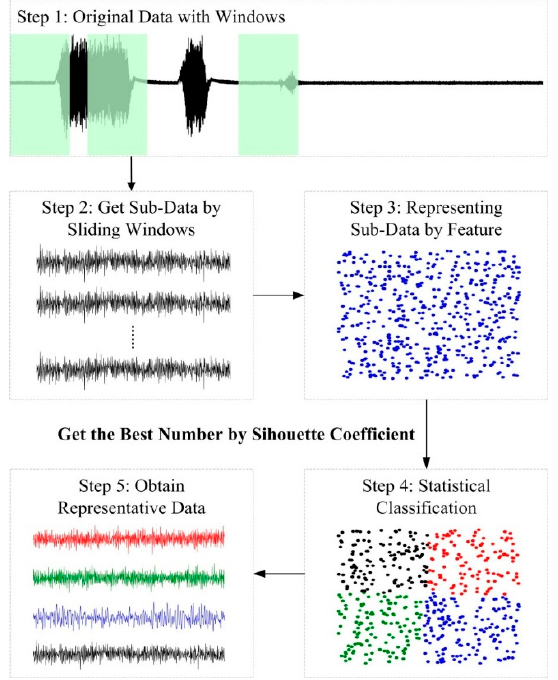
Figure 8. The flowchart of sliding windows method clustering algorithm (SWM-CA).